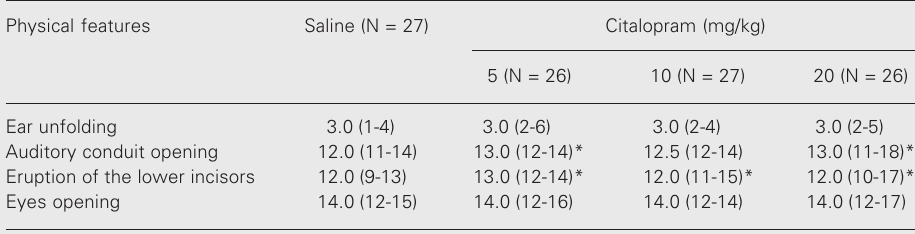
Table 1. Maturation (in days) of the physical features of suckling rats treated with citalopram from the 1st to the 21st day of life. Physical features